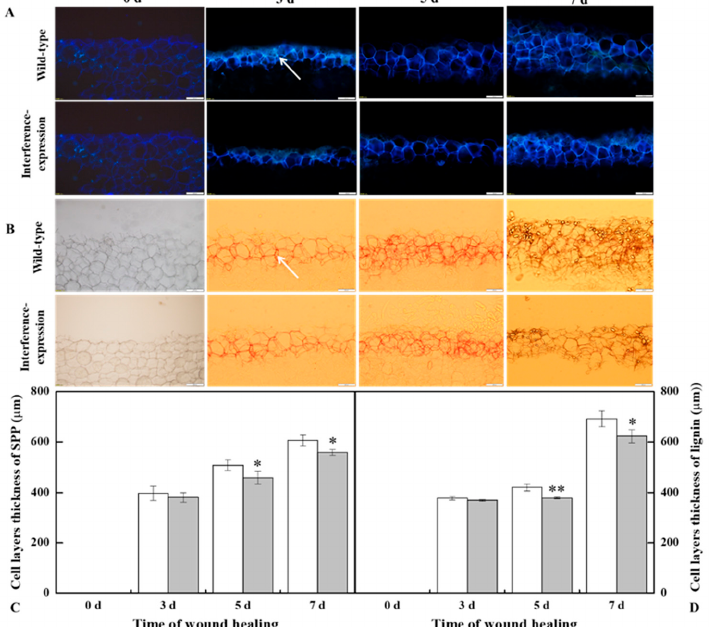
Figure 5. The interference expression of StMSD resulted in the less deposition of SPP ( A , C ) and lignin ( B , D ) at wounds of tubers during healing (arrows point at the SPP and lignin). Magnification = 10×, scale bar = 200 μ m. Bars indicate standard deviation (±SD). Asterisks represent significant differences (* p < 0.05; ** p < 0.01). Each column represents the mean of three replicates. The healing was carried out at ambient temperature (20–25 °C; RH 80–90%) in the dark. The RNAi line IntLn-1 was used in the experiment.